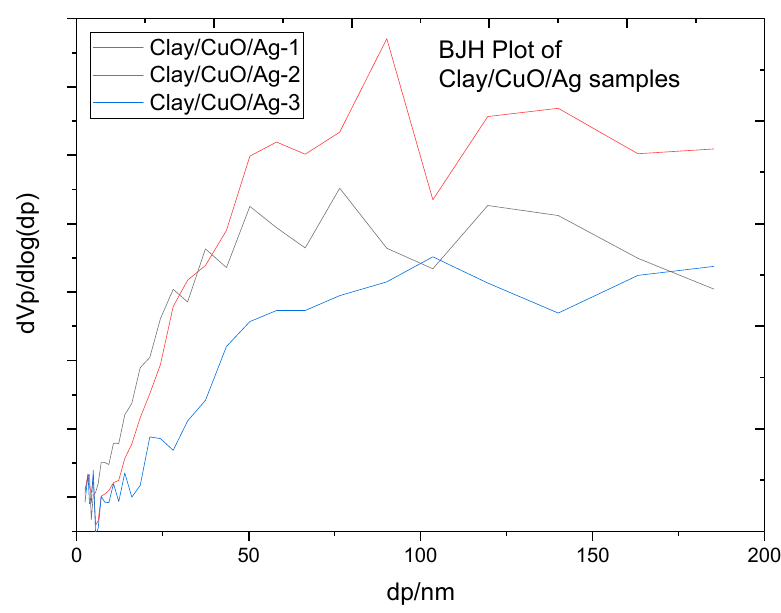
Figure 16. Pore size distribution of clay / CuO / Ag samples.